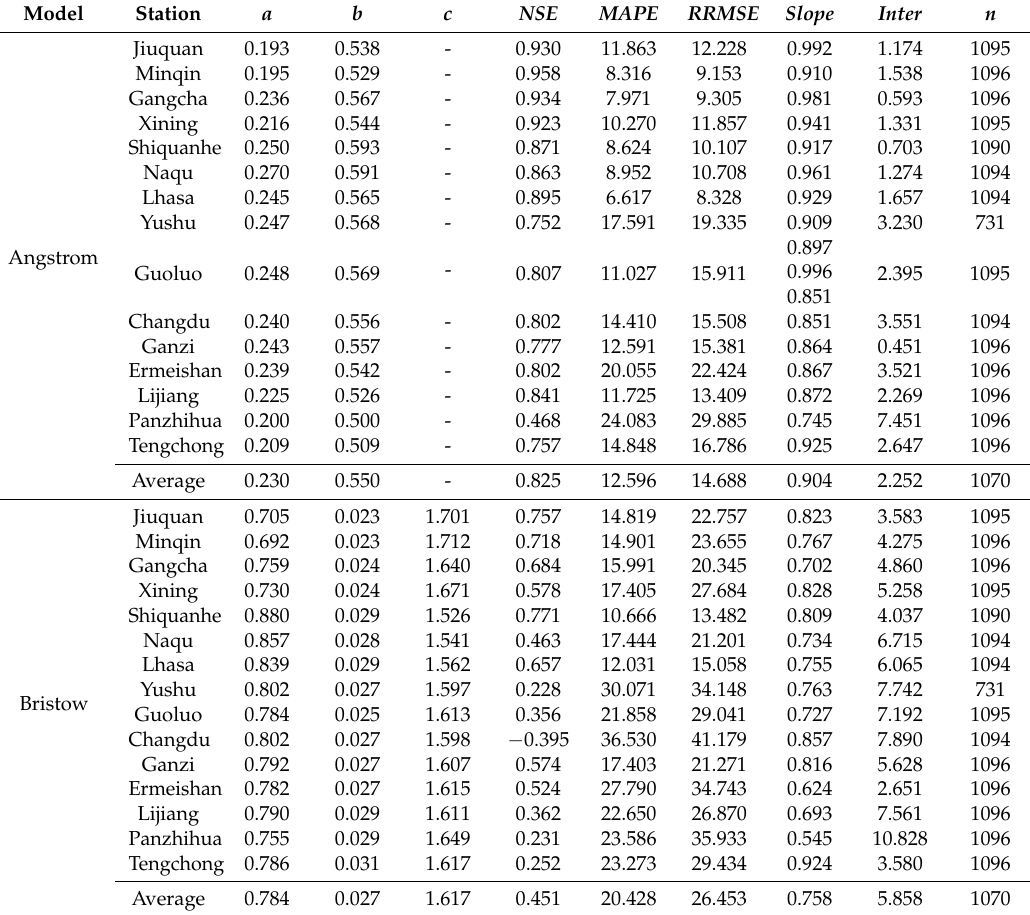
Table 5. Performance of the Angstrom- and Bristow-type geographical models using validation dataset from 2008 to